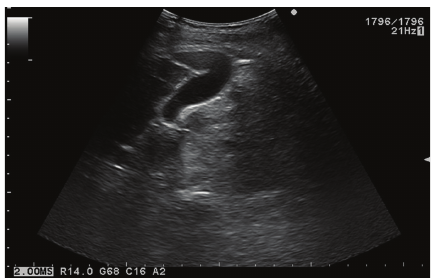
Figure 3: Long axis view of the gallbladder shows it extending from the hilum to the lateral border of the liver. We observed a folding of the fundus which is known as the “Phrygian cap” deformity.